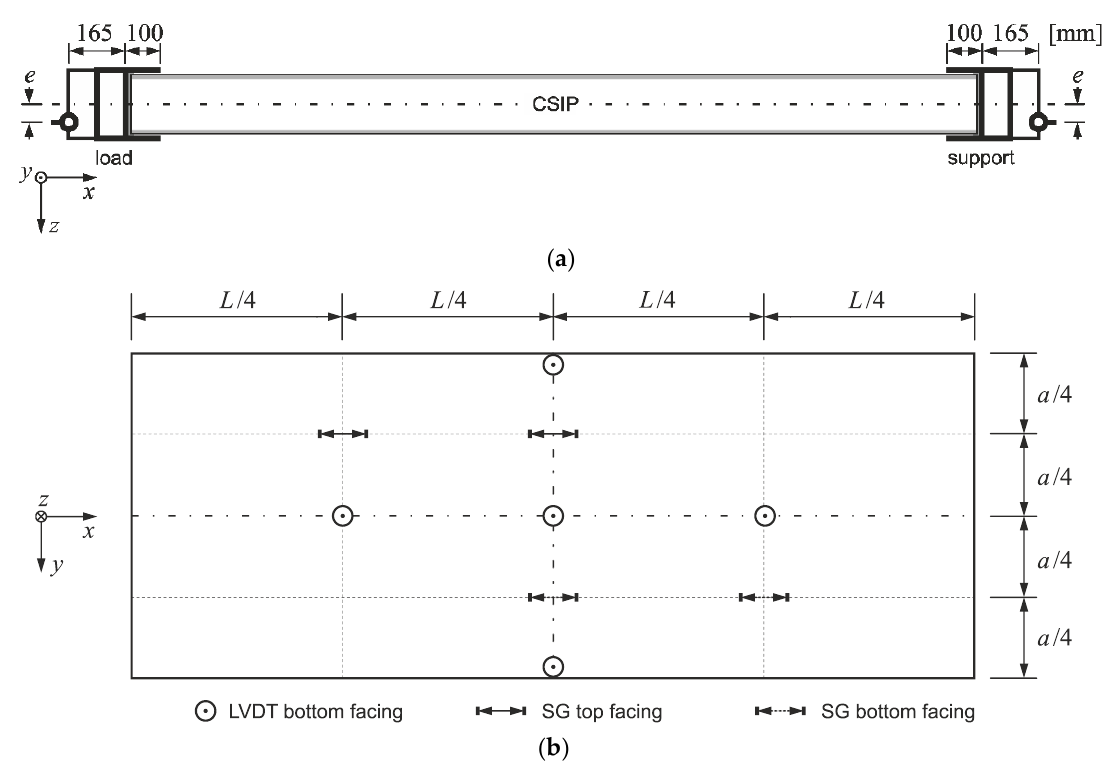
Figure 4. Schematic diagram of full-scale laboratory tests: ( a ) load and support, ( b ) positions of measuring devices.